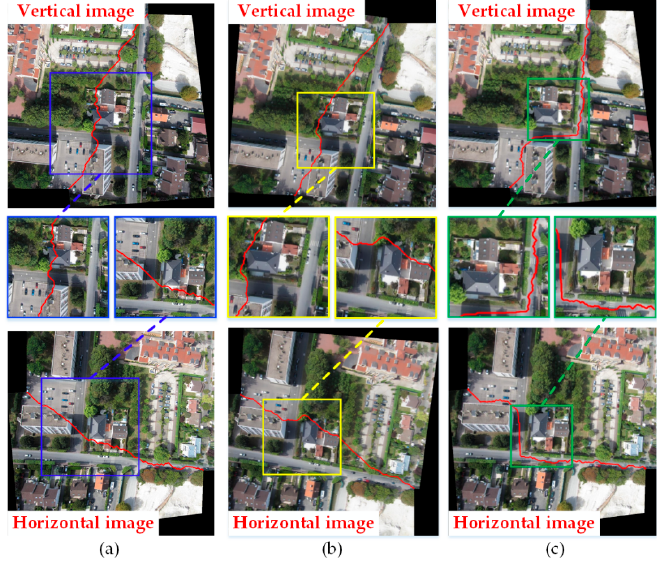
Figure 9. The seam lines of different searching algorithms under different situations. ( a ) Duplaquet algorithm; ( b ) OpenCV algorithm; ( c ) Our algorithm. algorithm; ( b ) OpenCV algorithm; ( c ) Our